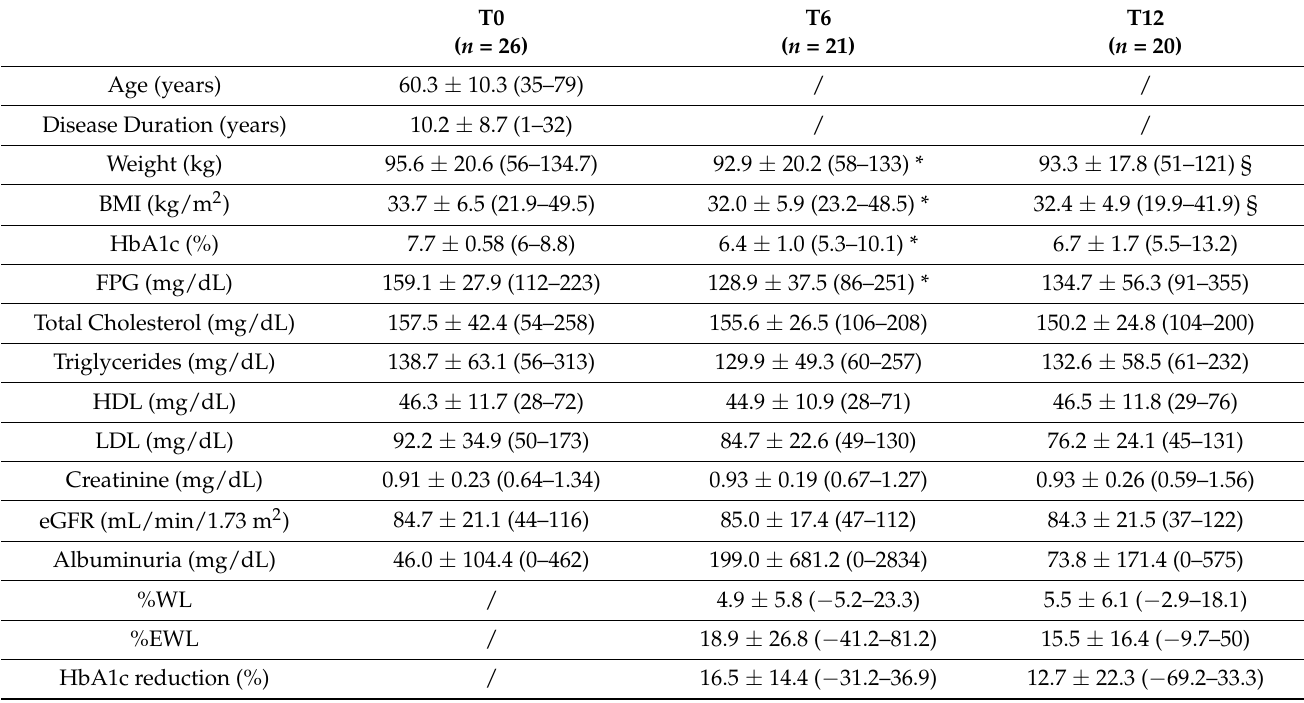
Table 1. Anthropometric measures and metabolic data of diabetic patients at baseline (T0) and after 6 (T6) and 12 (T12) months of GLP1-RA